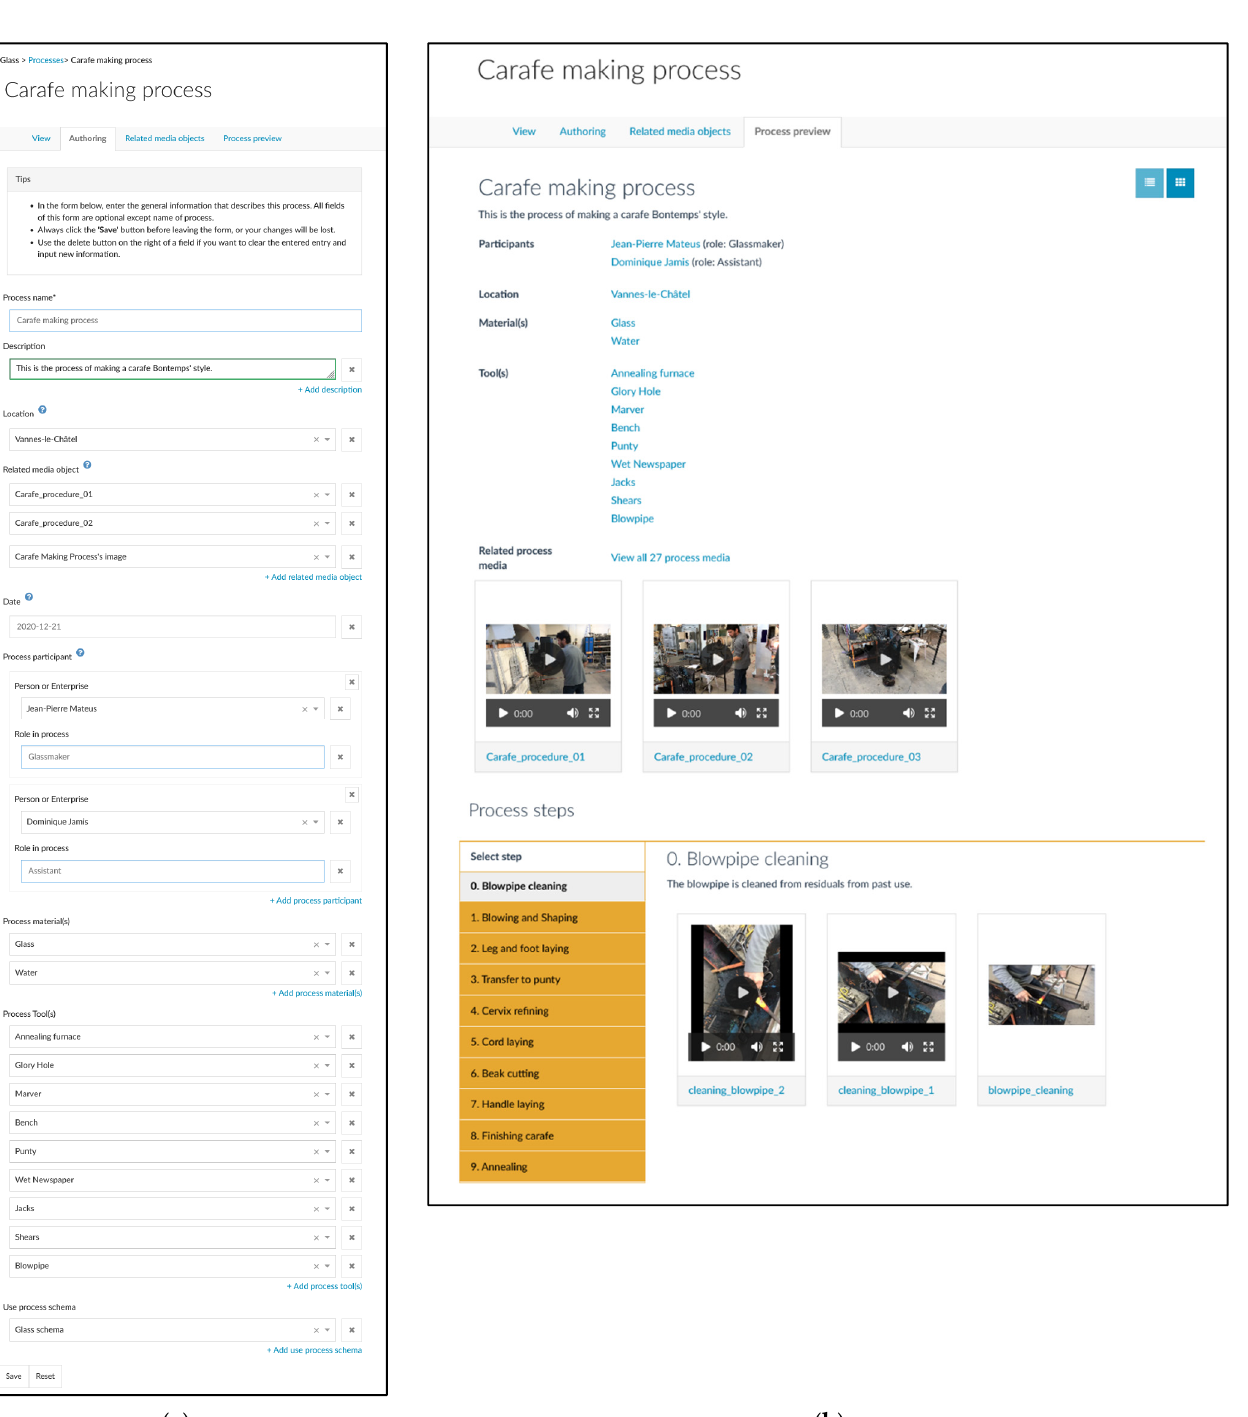
Figure 10. ( a ) Authoring processes, ( b ) Process preview.